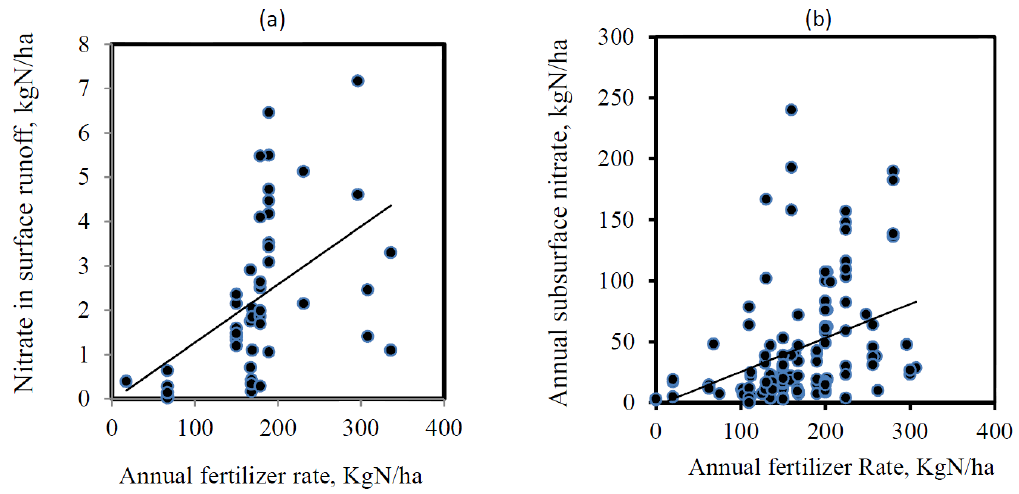
Figure 1. Nitrate in surface runoff ( a ) and nitrate leaching through subsurface runoff ( b ).